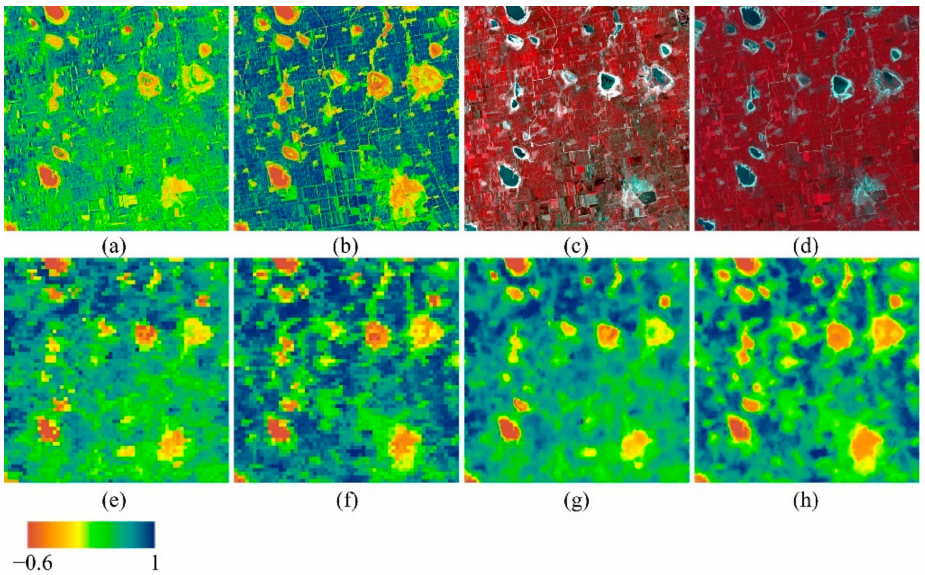
Figure 6. Test data for western Jilin Province: Landsat NDVI obtained on ( a ) 1 July 2018 and ( b ) 2 August 2018, false-color-composite Landsat images obtained on ( c ) 1 July 2018 and ( d ) 2 August 2018, ( e , f ) resampled MODIS NDVI for the corresponding dates, and ( g , h ) corrected MODIS NDVI for the corresponding